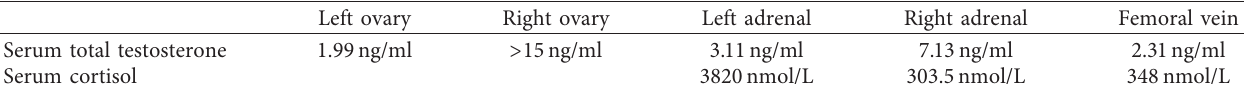
Figure 3: Bilateral ovarian/adrenal venous sampling: serum testosterone levels. Table 2: Bilateral ovarian/adrenal venous sampling.